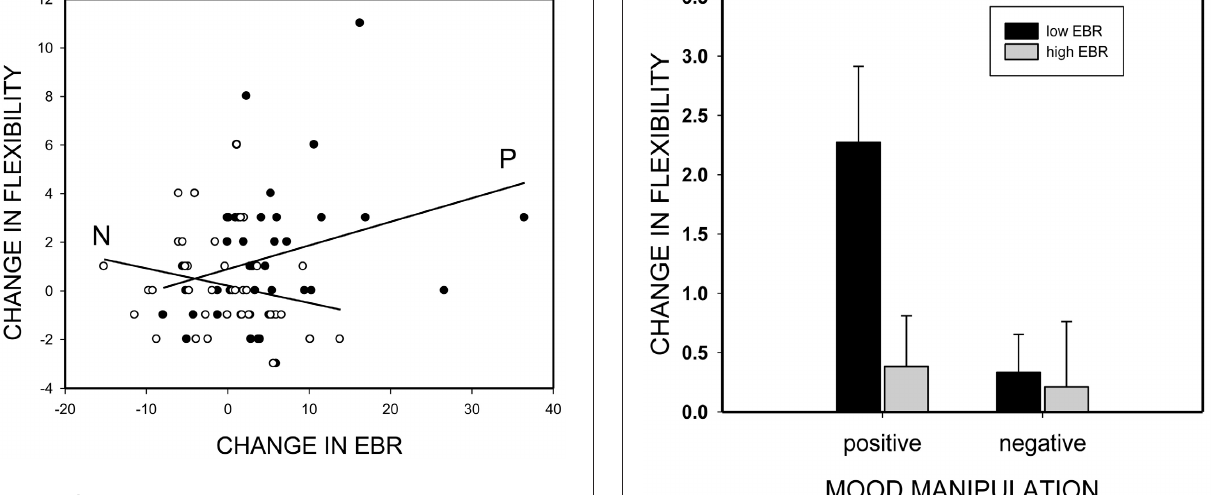
FIGURE 3 | Mood-induced change in divergent thinking performance (flexibility score post minus flexibility score pre mood induction) as a function of the mood-induced change in spontaneous eye blink rate (EBR). Empty circles and regression line N for participants with negative-mood induction; filled circles and regression line P for participants with positive-mood induction.